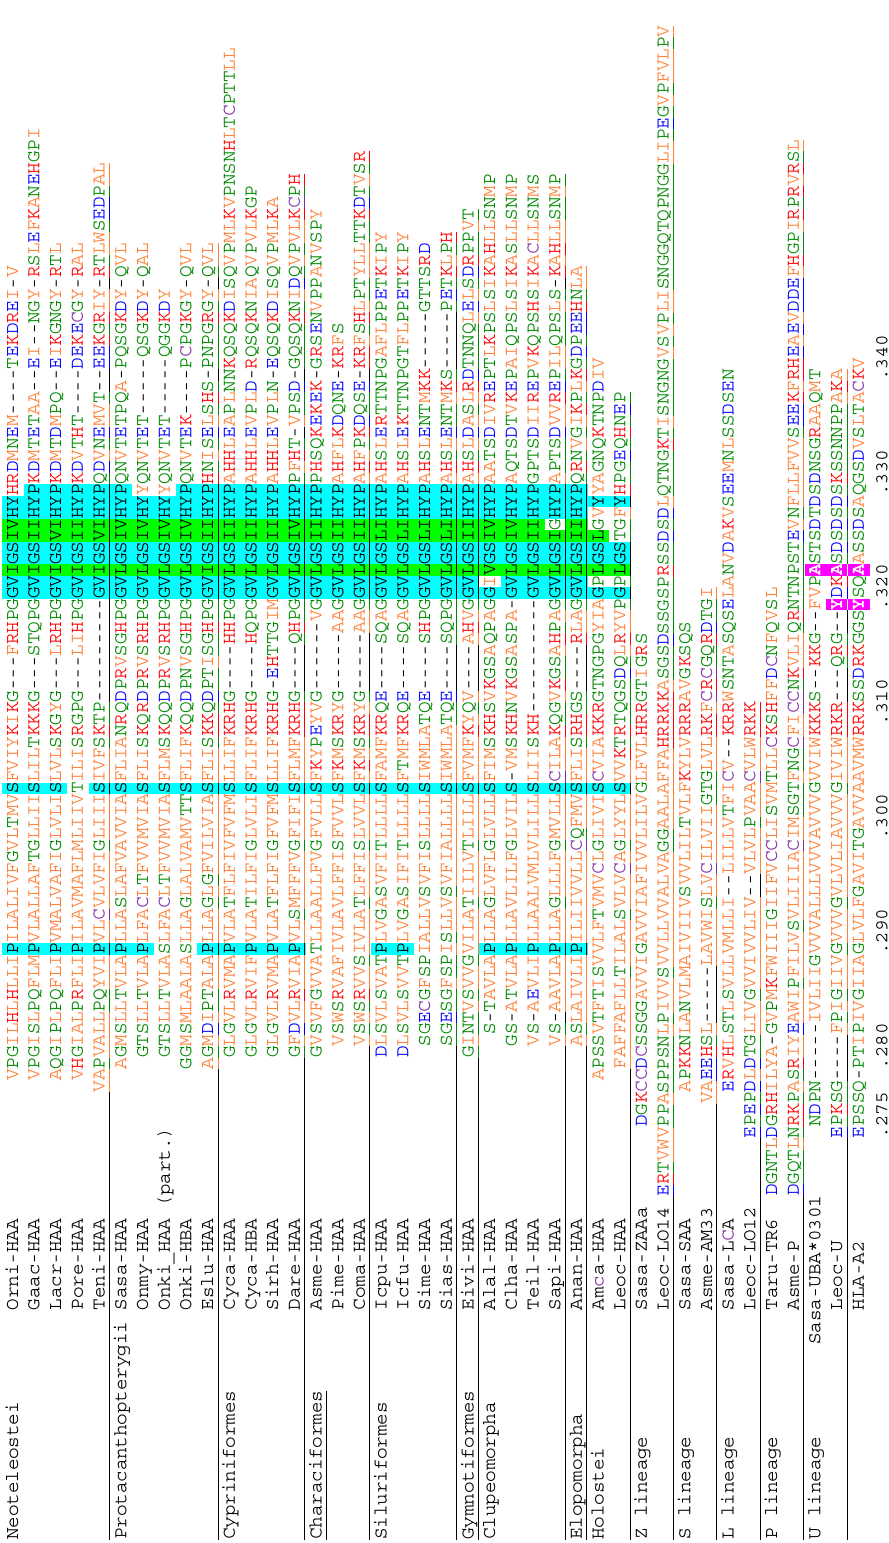
Figure 4. Alignment of deduced H lineage amino acid sequences with other representative MHC-I sequences. Color shading of residues highlights conserved features and is explained in the main text. The sequences are divided into leader, α 1, α 2, α 3, and CP / TM / CY regions, the borders of the first four domains being defined by (expected) exon borders. Numbers under the alignment are based on